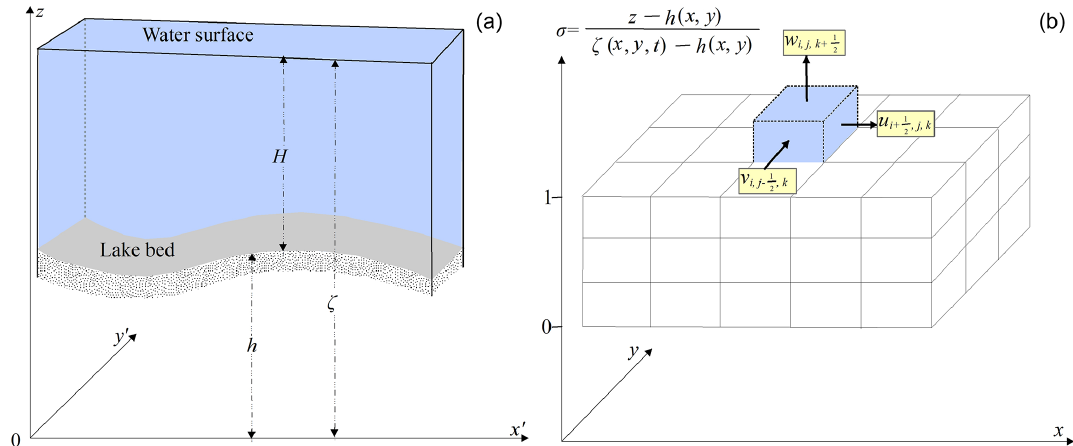
Figure 2. Lake bed elevation (h) , water level (ζ) , and water depth (H) in the Cartesian coordinate system (a) . The three components of lake current velocity in the i th ( x direction), j th ( y direction), and k th ( σ direction) grid of the mesh in the sigma (σ) coordinate system (b)